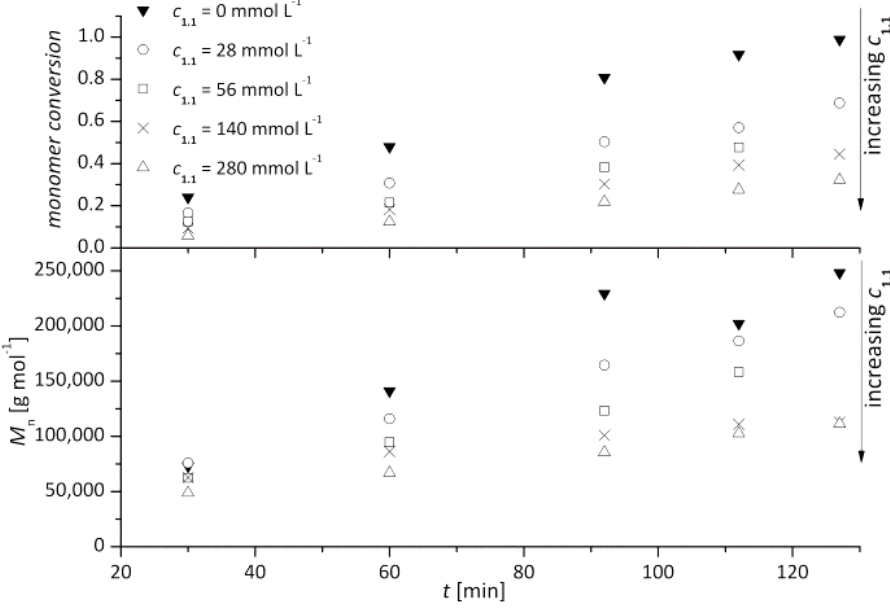
Figure 8. Development of the number average molecular weight, M conversion with the reaction time for a homopolymerization of NIPAm (filled symbols) and various copolymerizations of NIPAm and 1.1 using 0.6 mmol·L − 1 R AIBN in DMF at 60